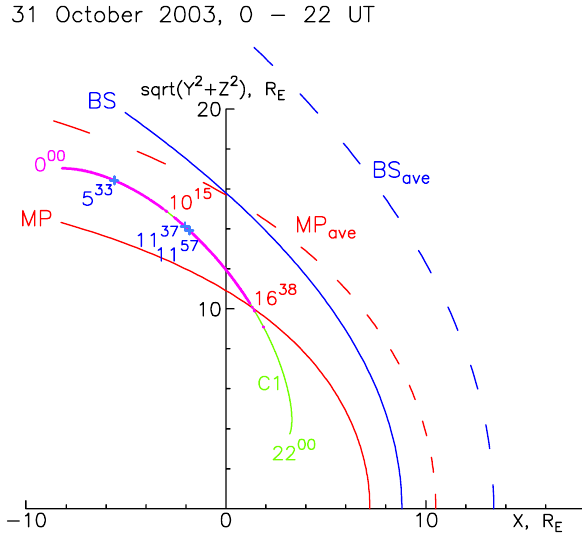
Fig. 6. 31 October 2003. Cluster 1 inbound trajectory in cylindrical coordinates. Lilac sections of orbit are in magnetosheath, green line is in magnetosphere. Times of bow shock crossings are marked by blue crosses. BS2 model (Cairns et al., 1995; Farris and Russell, 1994) bow shock is shown by blue lines and MP1 model (Shue et al., 1998) magnetopause by red lines: dashed curves for average solar wind parameters, solid curves calculated with parameters around 11:57 UT when the spacecraft crossed the bow